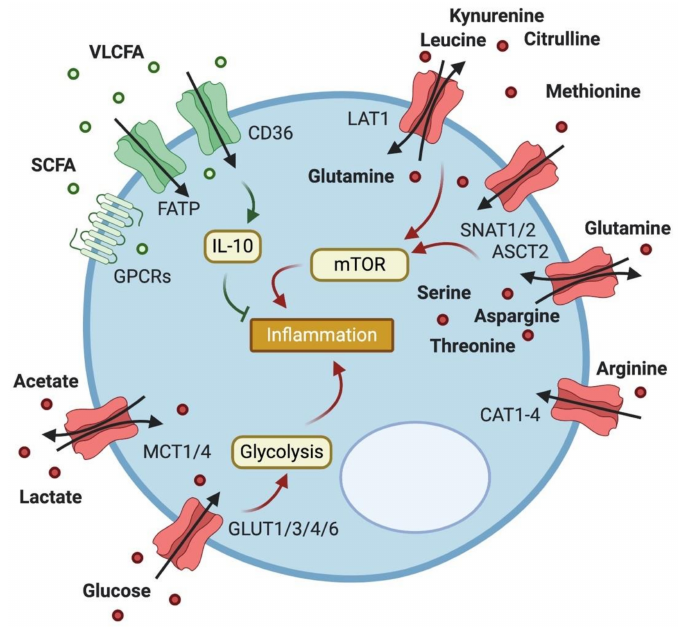
Figure 1. Expression of metabolite transporters on T cells and their impact on T cell function. T cells express a variety of transporters to facilitate their metabolic needs. Import of fatty acids (FAs) of various sizes reduces inflammation through FA oxidation and IL-10 production, while import of lactate and acetate boosts inflammation. Transporters of the GLUT family take up glucose to increase glycolysis in activated T cells, while amino acid (AA) transport drives inflammation mainly via mTOR